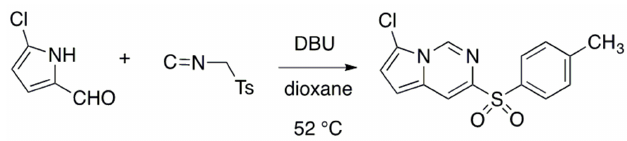
Figure 3 Reaction scheme.